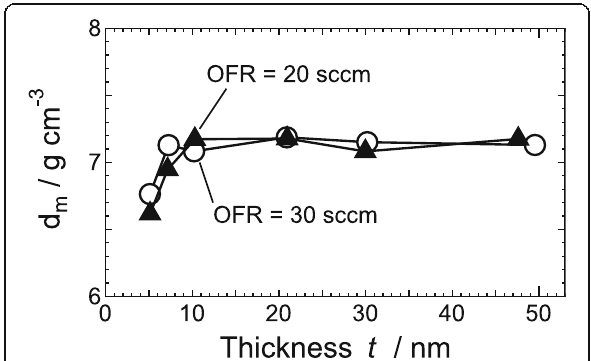
Fig. 3 Mass density d m derived from XRR measurement results of a - ITO films grown at an OFR of 20 sccm (triangles) or 30 sccm (circles) as a function of film thickness t